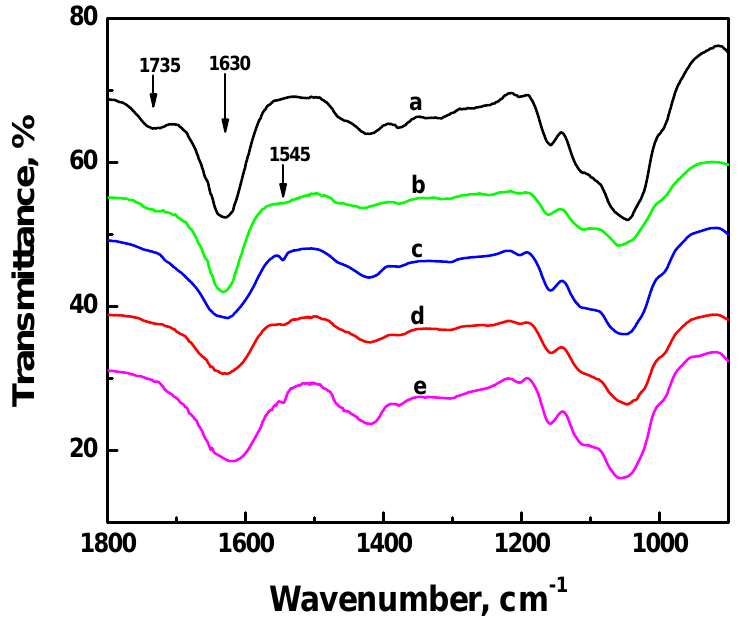
Figure 5. FTIR spectra of ONC: ( a ) alone, and coupled with: ( b ) Phe, ( c ) EMP, ( d ) Trp and ( e ) WRF.